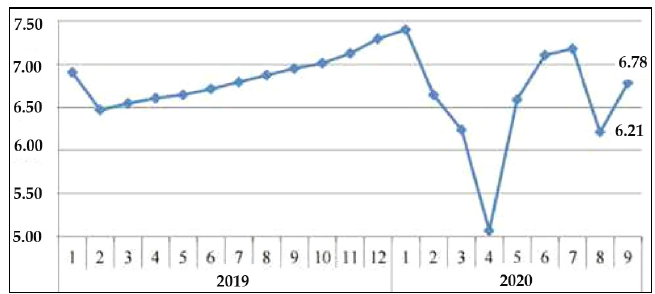
Figure 5. Weight of goods transported by seaway (million tons) (Vietnam Logistics Report 2020).